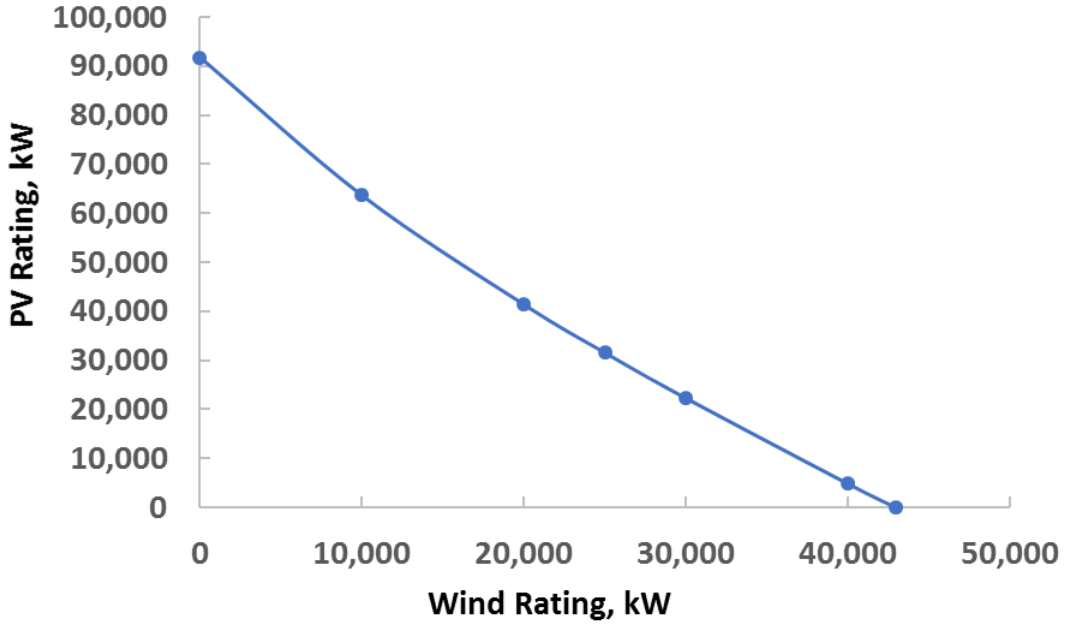
Figure 3. The combination of wind and solar installations power ratings.